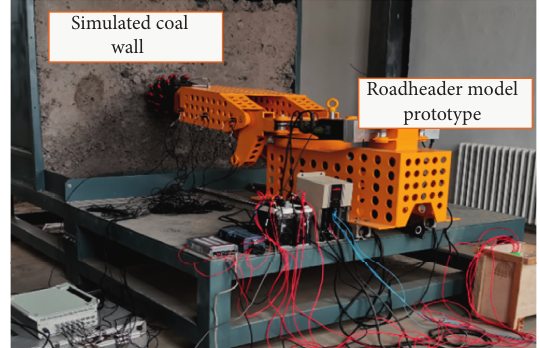
Figure 12: Roadheader model prototype and simulated coal wall.